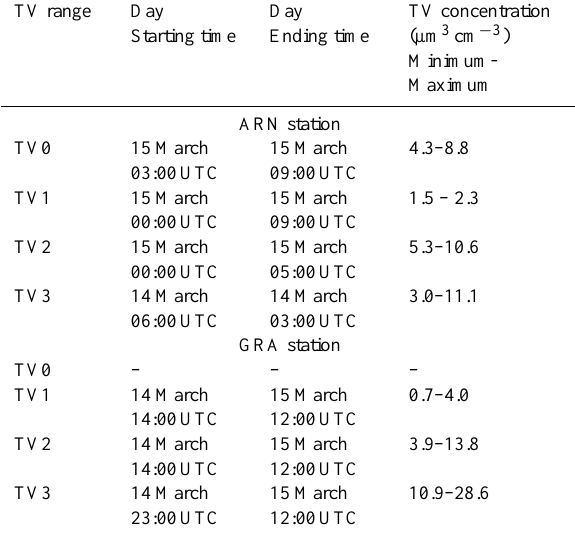
Table 5. Date and starting and ending times together with the max- imum and minimum TV concentration values as reached for each size range of the DDP episode in both ARN and GRA